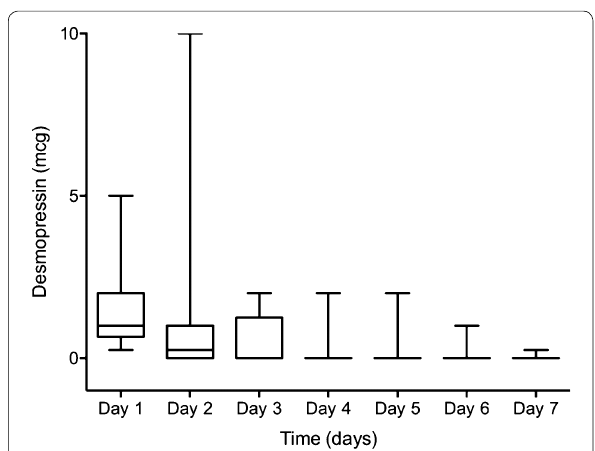
Fig. 2 Median daily desmopressin dose in patients who received desmopressin. Boxplot represents median, quartiles and minimum/ maximum values